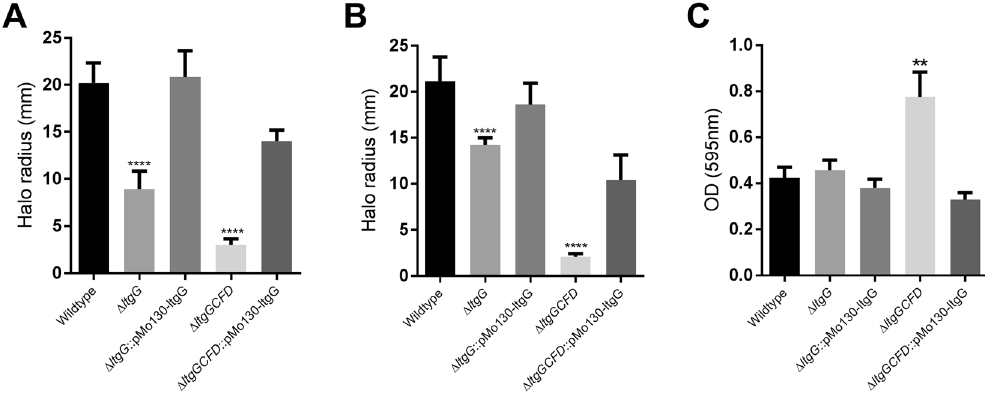
Figure 4. Δ lt gG has significantly reduced swimming and swarming motility but not biofilm production. Swimming ( A ) and swarming ( B ) motility assays were performed as described in Methods. For assessment of biofilm formation bacteria were stained with crystal violet and absorbance of ethanol extracts measured at 595 nm ( C ). Motility data are shown as mean values with error bars representing standard deviation, three biological replicates with 3 technical replicates per experiment were performed. Biofilm data are shown as mean values with error bars representing standard error, four biological replicates with 8 technical replicates were performed per experiment. One-way ANOVA analysis was performed comparing mutant strains to wildtype, ** p < 0.01, **** p < 0.0001.